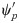
Φ is the source region/image, Ω is the target region and ∂Ω represents the boundary between the source region and the target region.
ψ
p is the patch that will be filled, ψp′ stands for a bigger patch having the same center p with ψ
p.